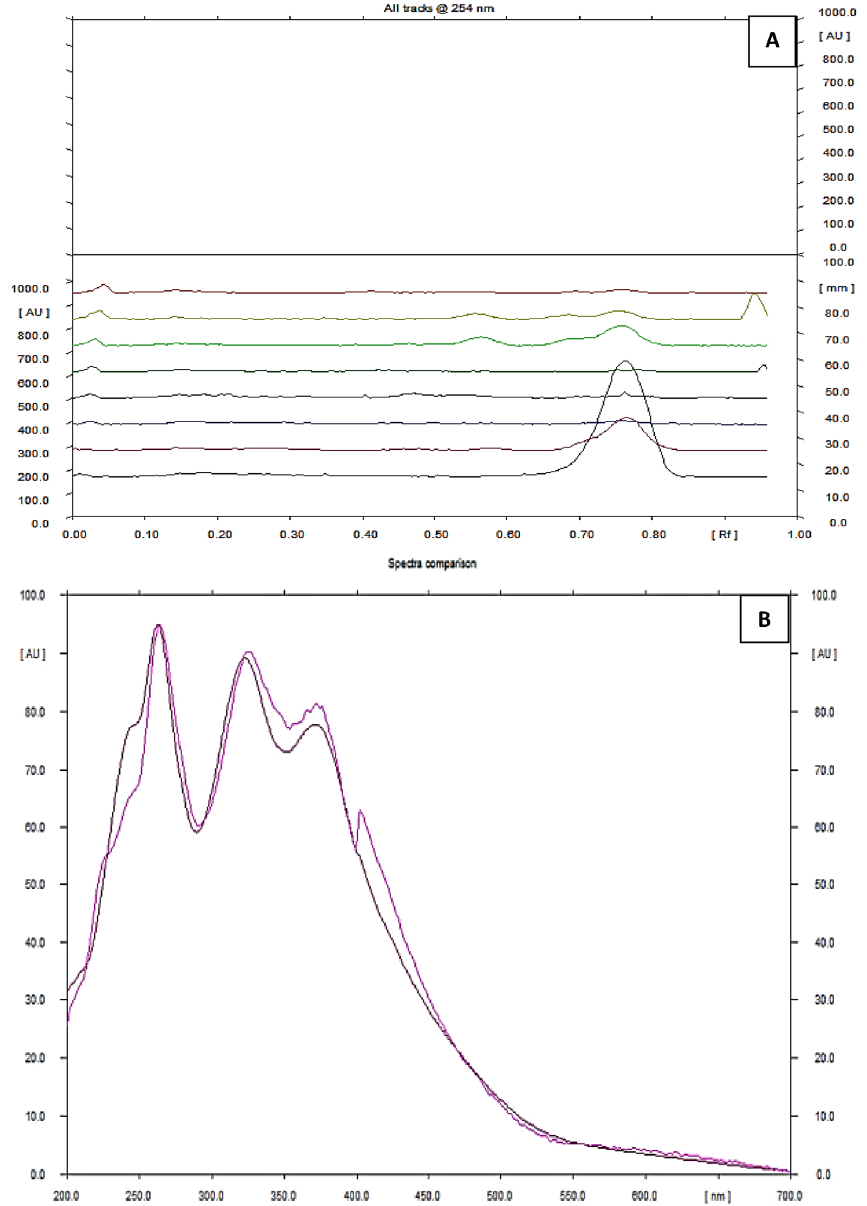
Figure 3. Comparison of reference compound (Track 1) with F1 (Track 2) by using Densitometric-HPTLC ( A ) and Overlay spectra ( B ) of reference compound with F1 at λ =